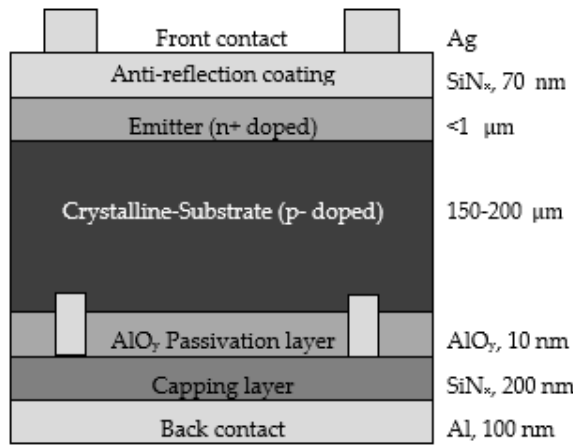
Figure 4. Schematic representation of the cross-section of a Passivated Emitter and Rear Cells (PERC) solar cell including a description of the different layers and its thickness.